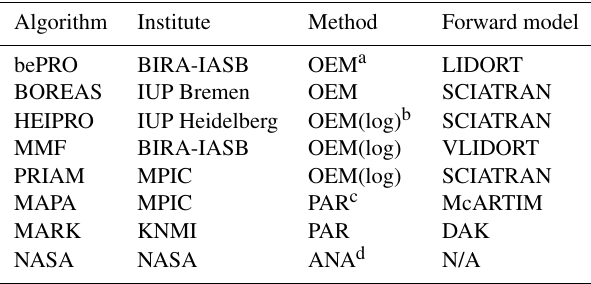
Table 1. MAX-DOAS retrieval algorithms participating in this